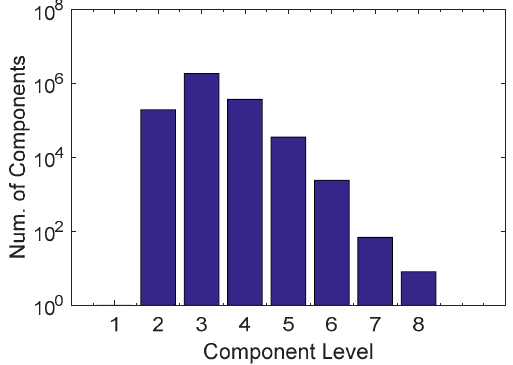
Figure 8. Distribution of component level in a dmoz name set.